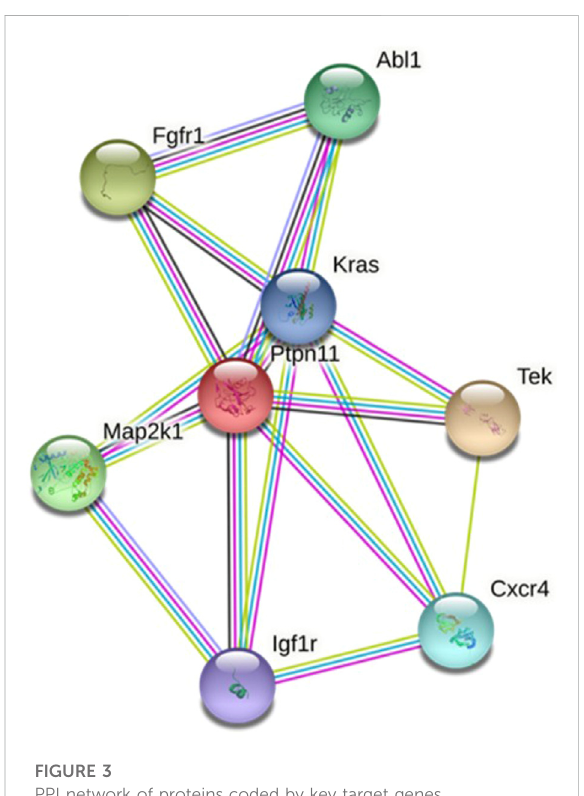
FIGURE 3 PPI network of proteins coded by key target